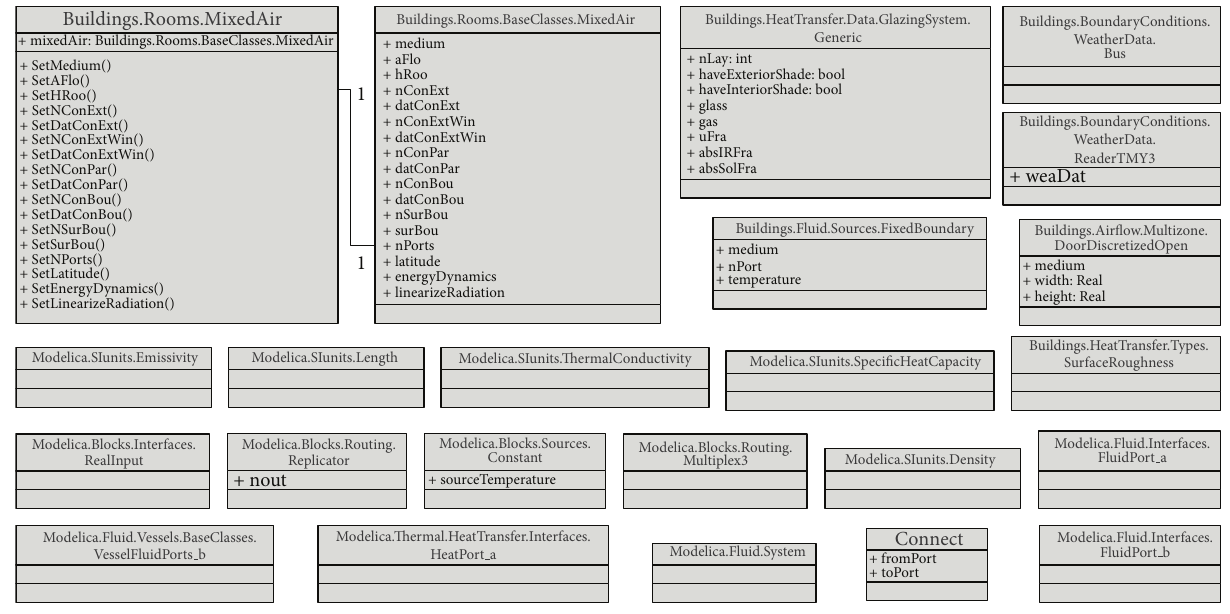
Figure 5: Class diagram of the Modelica model